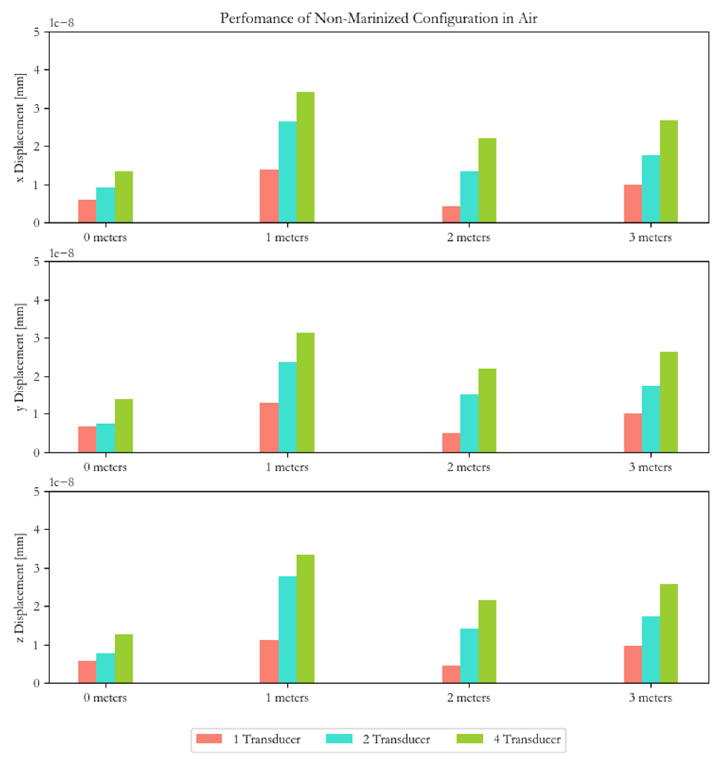
Figure 14. Performance of non-marinized configuration in air.